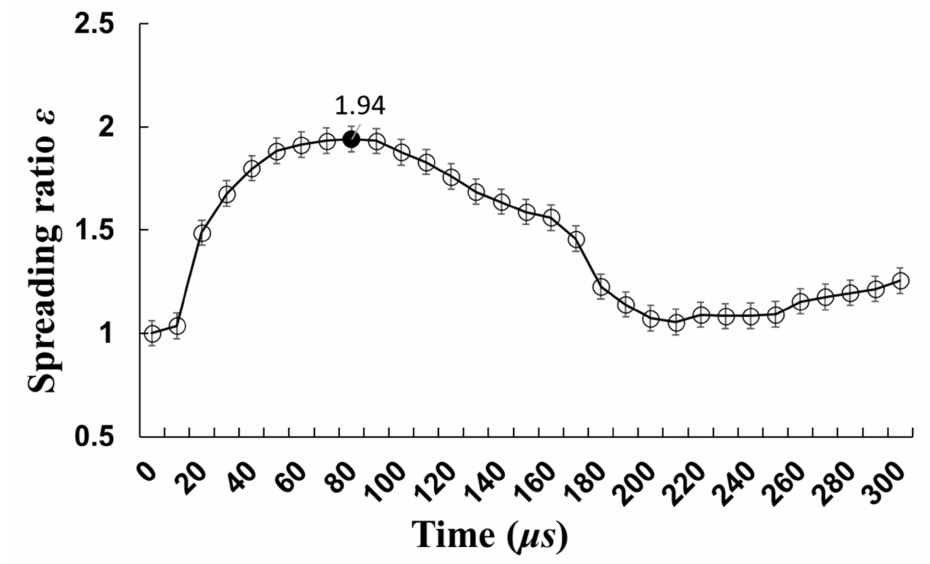
Figure 5. The simulation result of binder droplet spreading ratio against time based on the parameter of our 3D printing